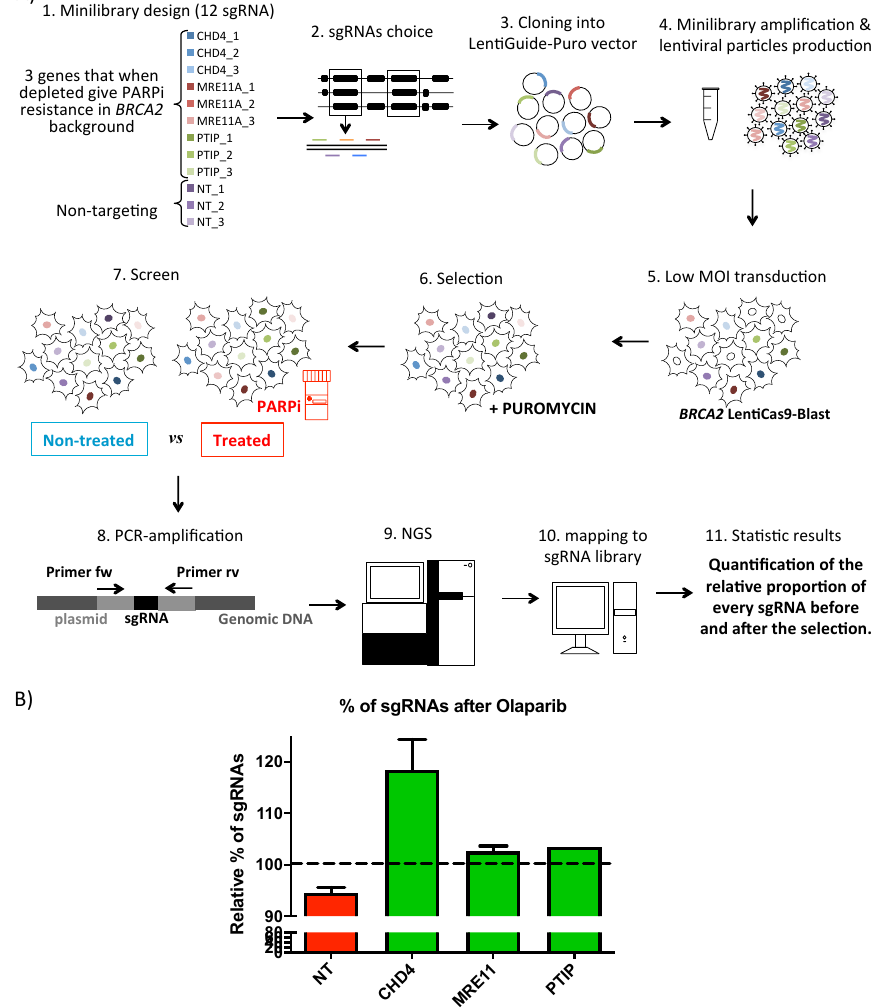
Figure 2. ( A ) Proof of principle CRISPR/Cas screen. 1. Minilibrary design with 3 sgRNAs for each gene of interest (3 genes that when depleted give PARPi resistance in BRCA2 background) plus 3 NT sgRNAs. 2. sgRNAs choice (at 5 (cid:48) common exons, with minimal off-targets). 3. sgRNAs cloning into LentiGuide-Puro vector. 4. Minilibrary constructs amplification and lentiviral particles production. 5. Low MOI transduction into BRCA2 fibroblast cells previously transduced with the plasmid LentiCas9-Blast. 6. Puromycin selection of cells with transduced sgRNAs, during 9 days. 7. Screen: non-treated and treated samples collection, after 7 days of 100 nM olaparib. 8. PCR of the sgRNA region. 9. NGS by MiSeq. 10. FASTQ files analysis and mapping to sgRNA library. 11. Statistic significant candidate hits by quantification of the relative proportion of every sgRNA before and after the selection. ( B ) Relative percentage of sgRNAs in olaparib treated samples versus non-treated. Average of the three-targeted genes and the NT sgRNAs. Only sgRNAs with significant p -values from the student t-test statistics are shown. Values: CHD4 118.4%, 2 sgRNAs; MRE11A 102.6%, 3 sgRNAs, PTIP 103.5%, 1 sgRNA and NT 94.5% data from four sgRNA with no significant p -values (CHD4_3, PTIP_1, PTIP_3 and